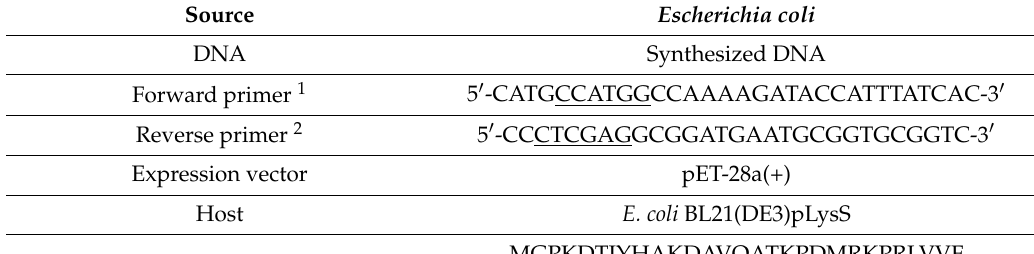
Table 1. Production specifics for